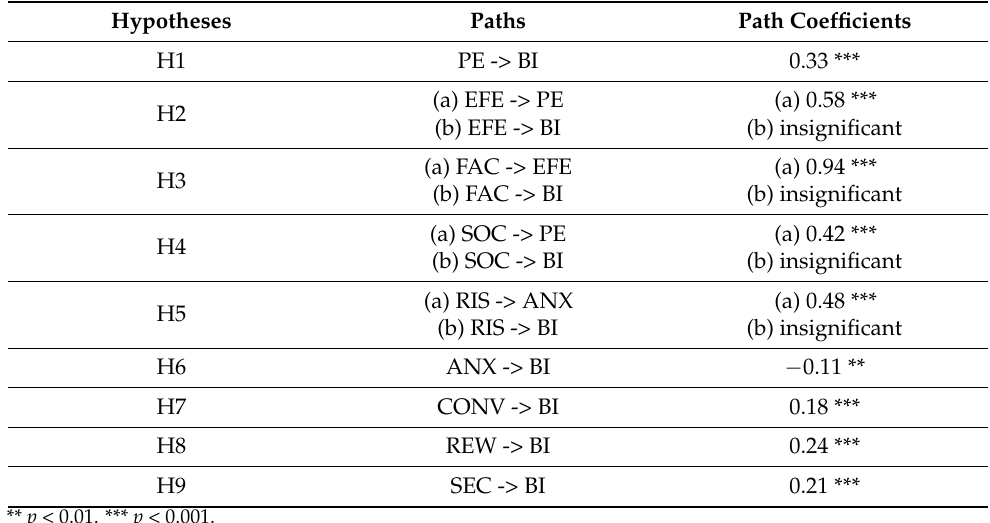
Table 4. Outcome of hypotheses testing.